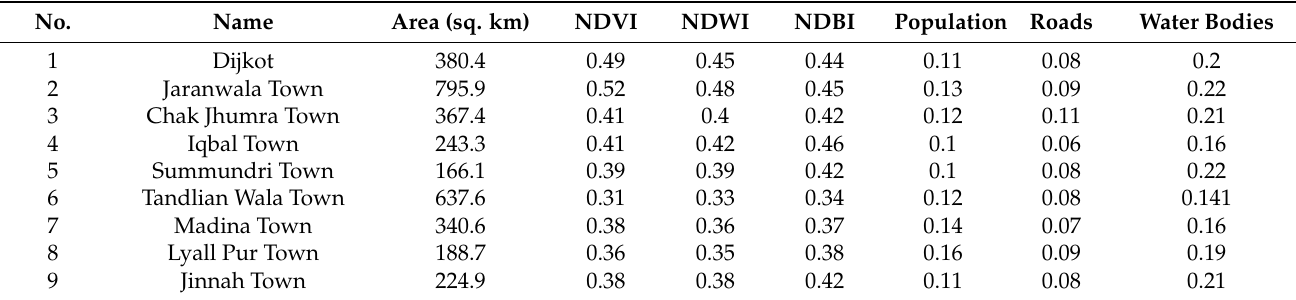
Table 2. Relative ranked mean values of the indices and